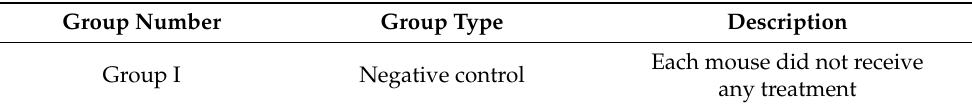
Table 1. Experimental groups in anti-psoriatic activity